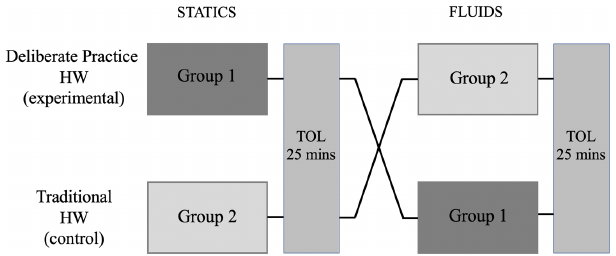
FIG. 1. Schematic showing the crossover study design of the targeted experiment. Students are randomly assigned to two groups and each student experiences both homework (HW) conditions across two physics topics (statics and fluids). A 25 min-long test of learning (TOL) is administered after each HW, for each